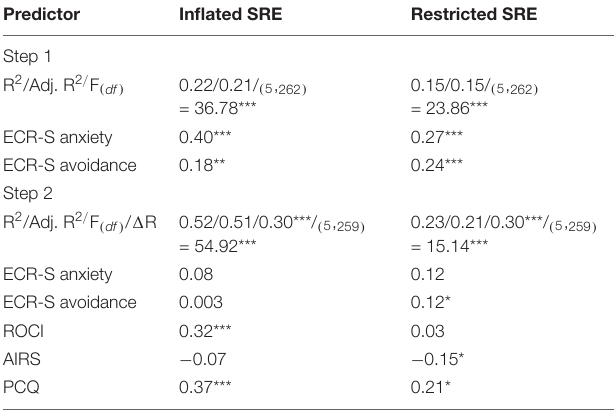
TABLE 2 | Prediction of inflated and restricted SRE using ECR-S anxious and avoidant attachment, ROCI, AIRS and PCQ ( n = 460).